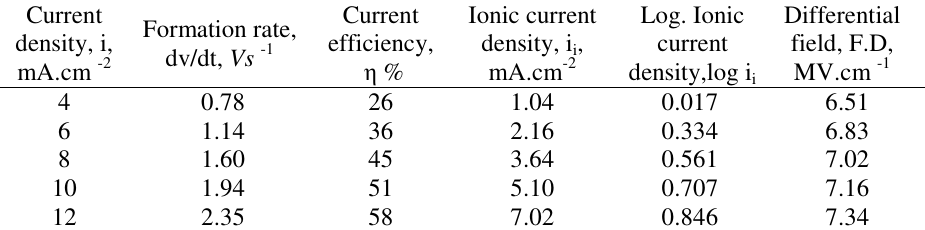
Table 3. Data on the anodization of Zr-2 in 0.1 M ammonium hydroxide. Current density, i,